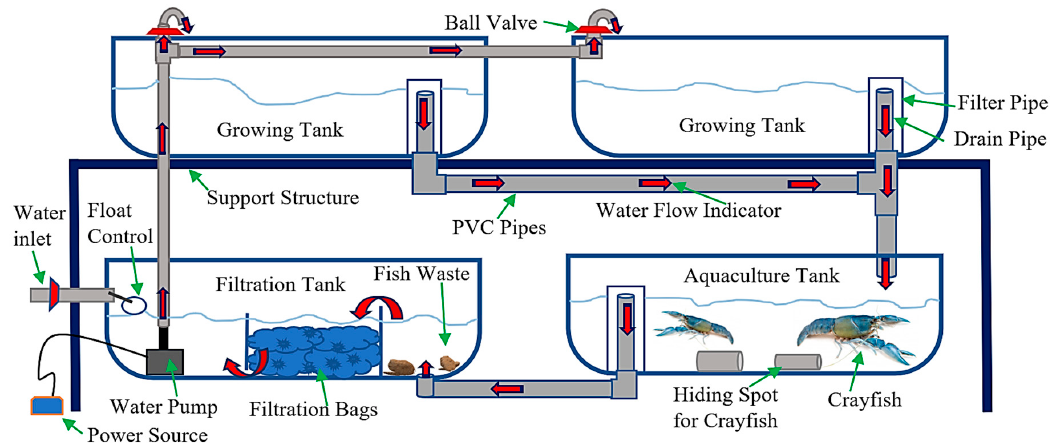
Figure 2. Schematic diagram of the general design of the four aquaponic growing systems used in this experiment.